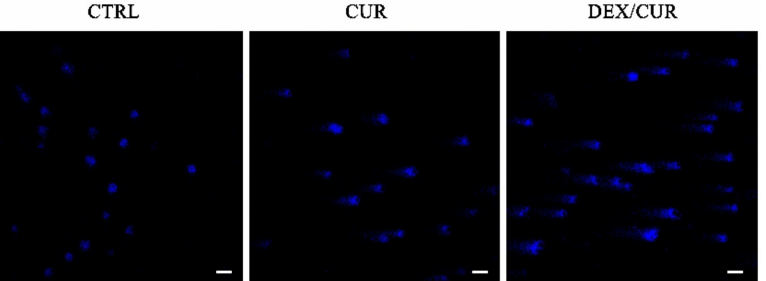
Figure 5. Fluorescent microscope images (scale bar 25 µ m, magnification 200 × ) of PC-3 DNA damage analyzed by Comet assay after 36 h treatment with CUR and DEX/CUR at 20 µ M CUR equivalent concentration.